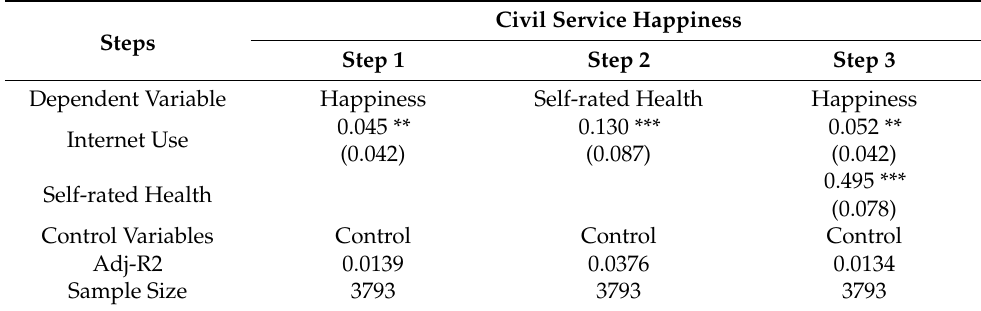
Table 8. Estimated results of mediating effects of self-rated